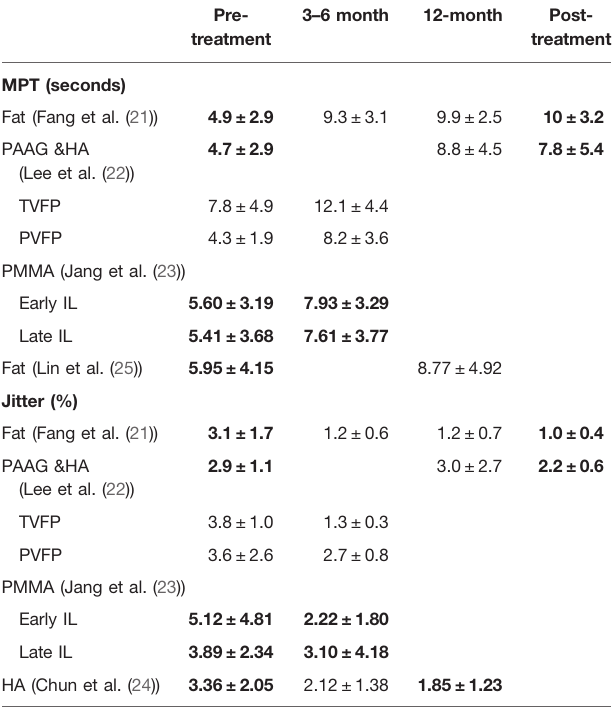
TABLE 2 | Compare the effects of ILs for post thyroid surgery UVFP with different injection